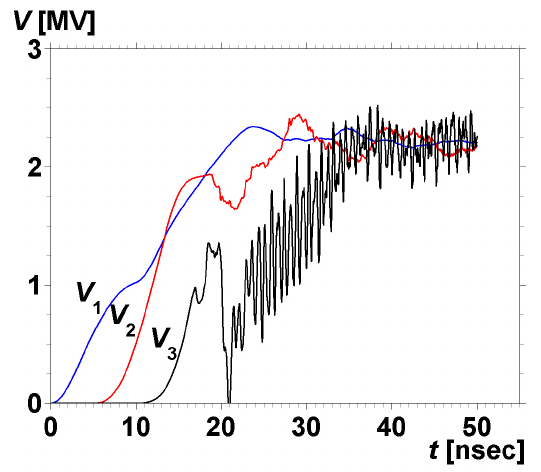
FIG. 15. (Color) Same as Fig. 9(a), for the geometry of Fig.